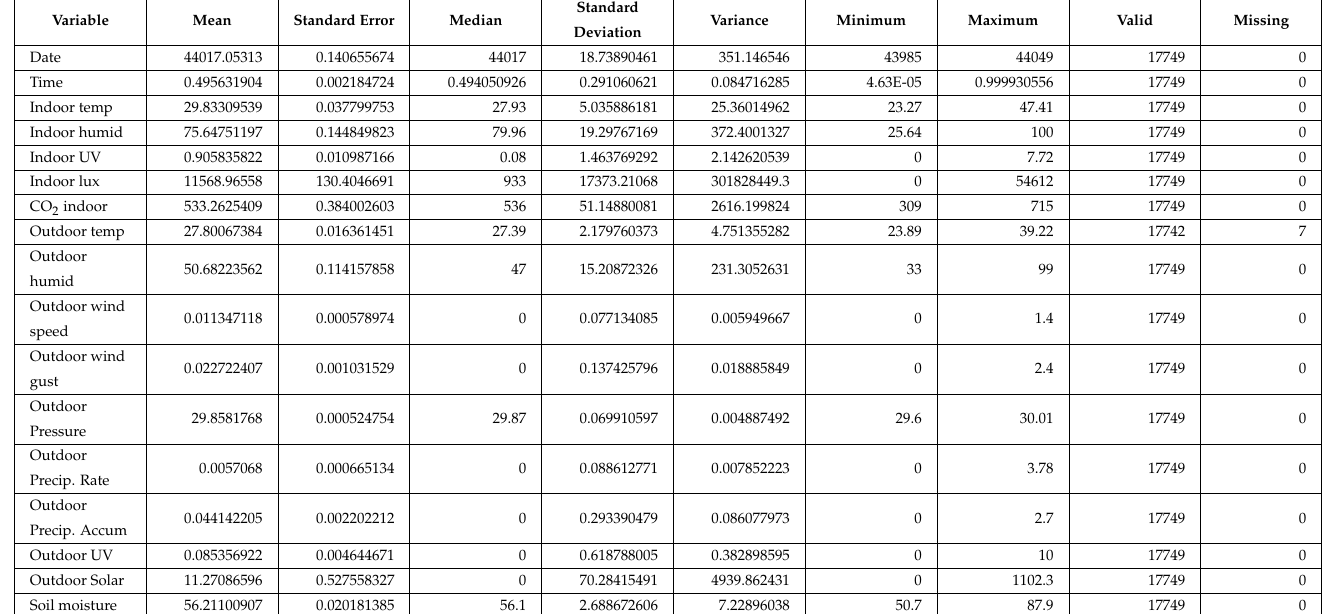
Table 3. Descriptive statistics for the dataset.